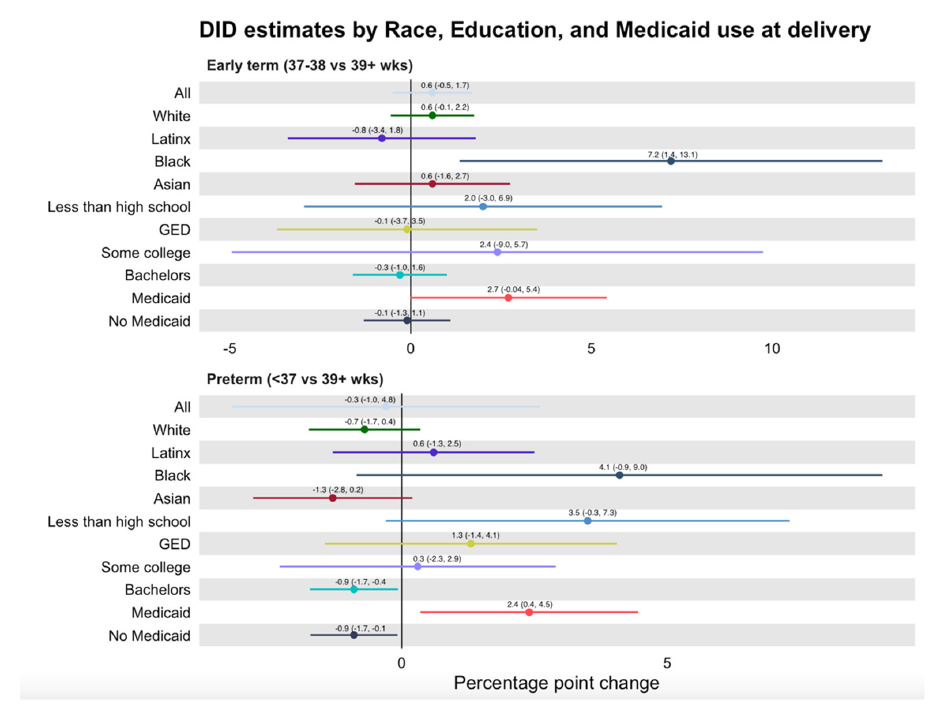
Figure 3. Early term and preterm DD estimates by race, education and Medicaid use at delivery.